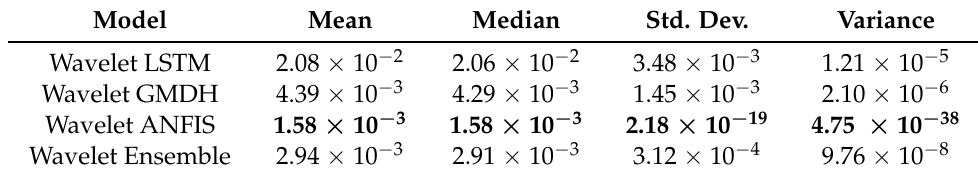
Table 8. Statistical evaluation of models with wavelet